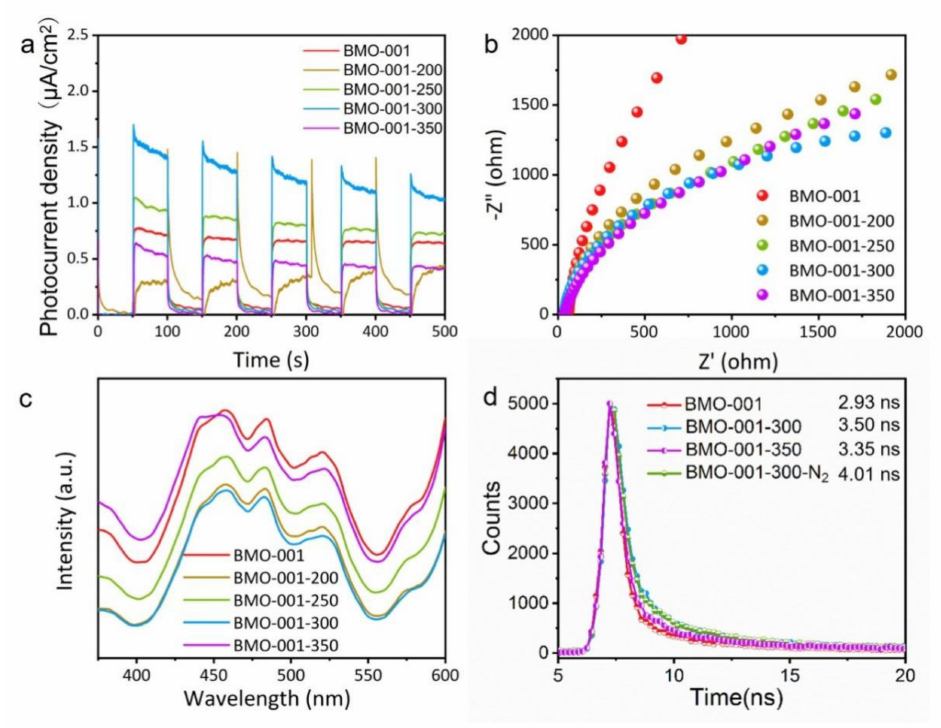
Figure 3. Photocurrent tests ( a ), EIS ( b ) and steady-state photoluminescence spectra ( c ) and time- resolved transient photoluminescence decay spectra ( d ) of as-prepared Bi 2 MoO 6